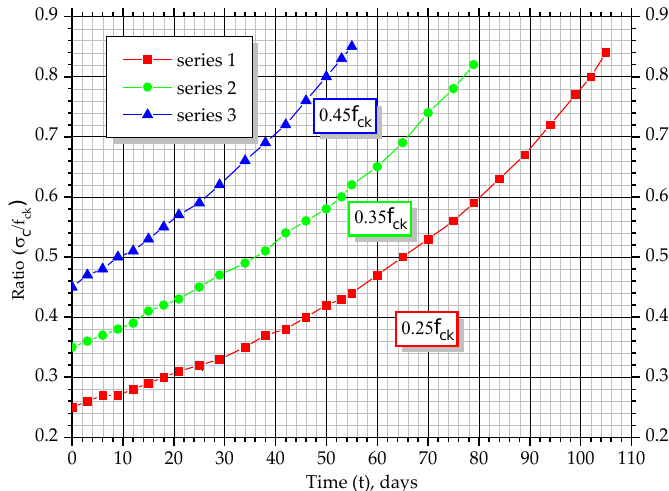
Figure 12. Changes of average values of σ c / f ck over time.